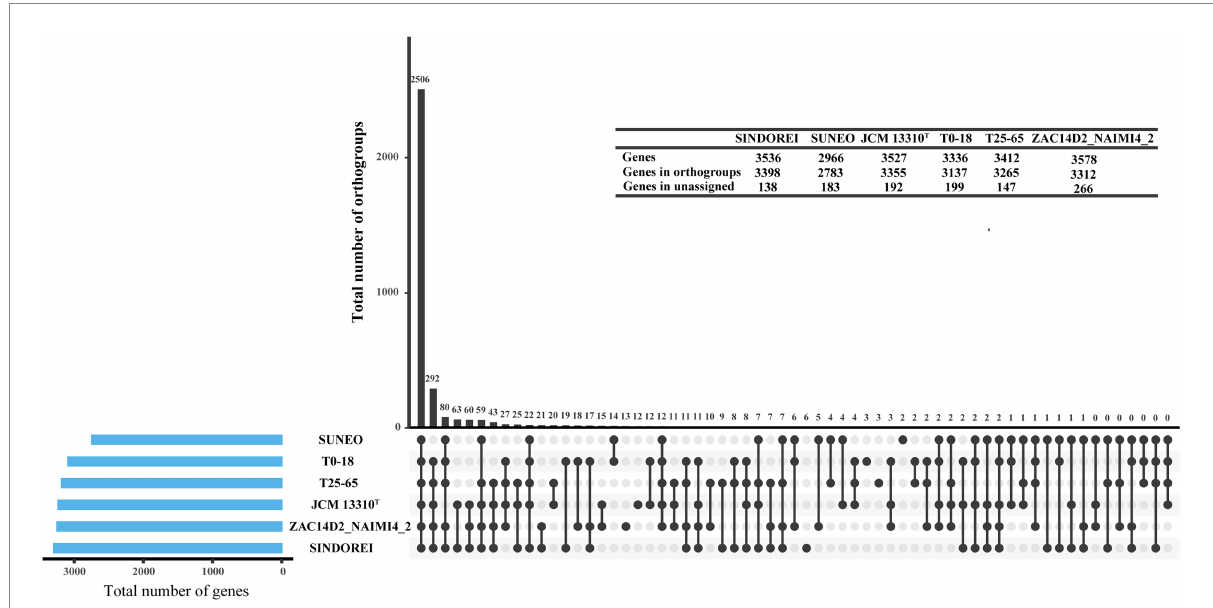
FIGURE 4 Groups of orthologous and paralogous genes (i.e., orthogroups) identified in the six Stenotrophomonas acidaminiphila strains used in this study. The vertical bars show the number of orthogroups exclusive to the strains marked as lower dots in the matrix. Horizontal bars represent the total number of genes in each strain.